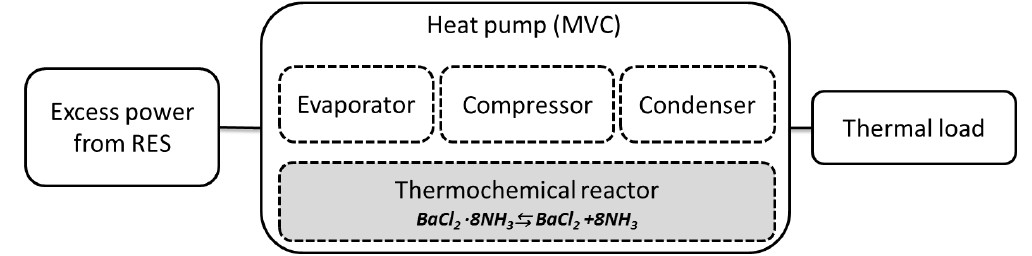
Figure 6. PtH/TCTES system developed by Ferrucci et al. [174] and by Fitò et al. [320]